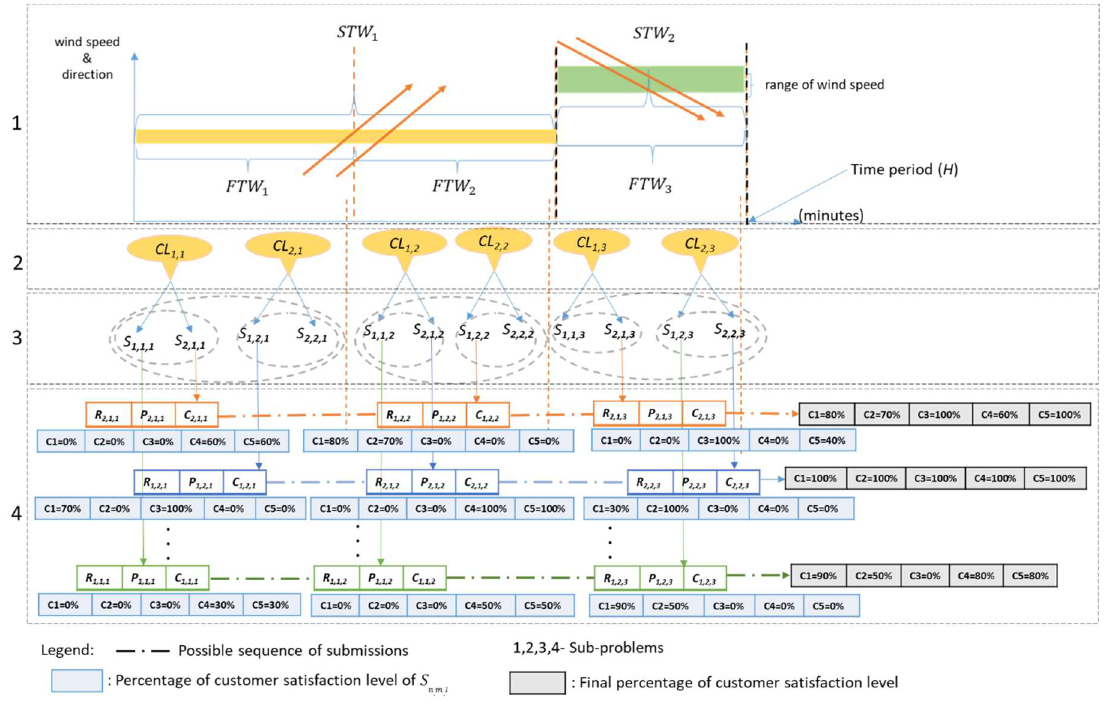
Figure 4. Proposed solution approach.